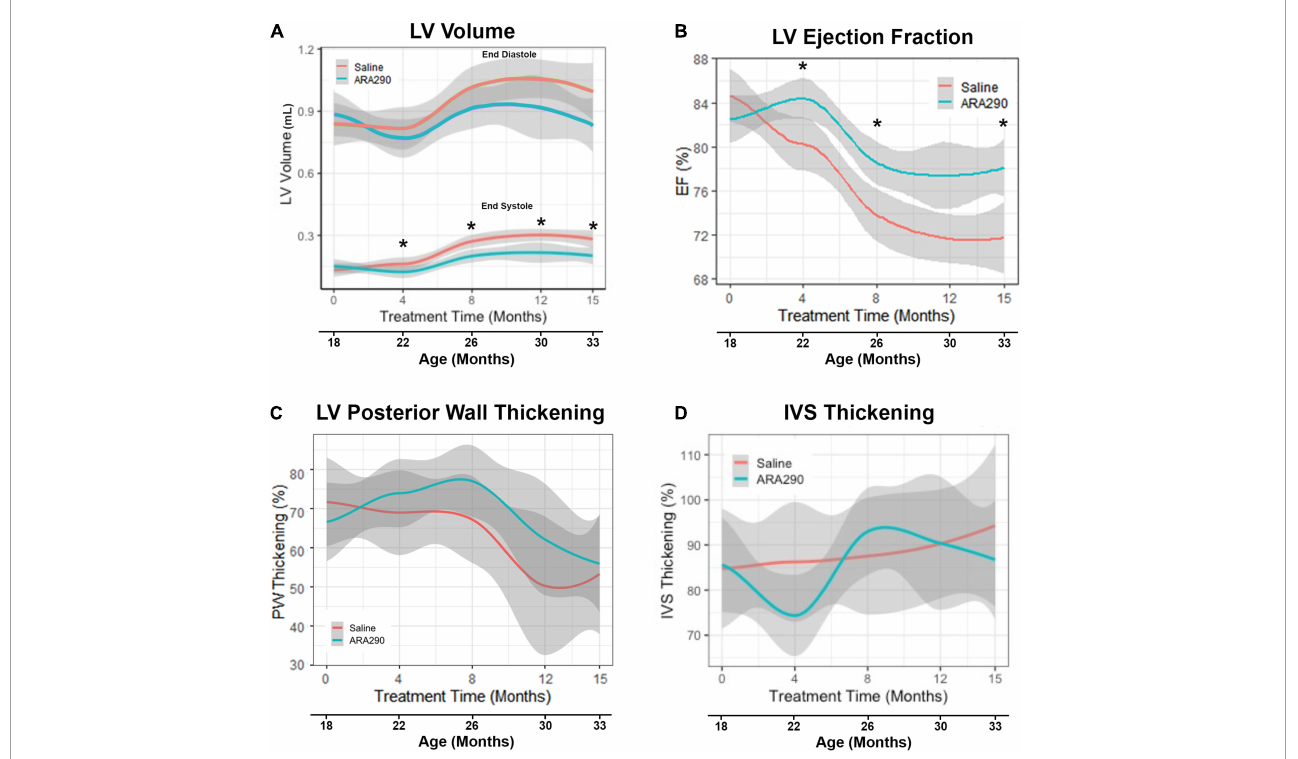
FIGURE1 Loess smooth curve (Red = Saline, Blue = ARA290) with 95% confidence intervals (gray) depicting the age-associated changes in left ventricular volume (A) , ejection fraction (B) , posterior wall thickening percentage (C) , and interventricular septum thickening percentage (D) . Statistically significant interactions between treatment groups are shown (* P <